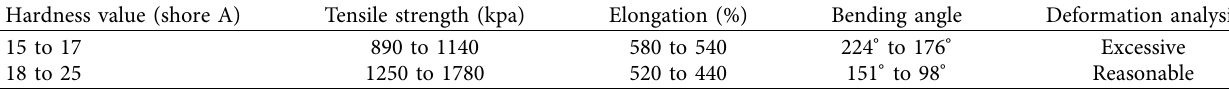
Table 4: Comparison of calculation results of the 601 room temperature vulcanized silica gel with different ranges of hardness value. Hardness value (shore A)